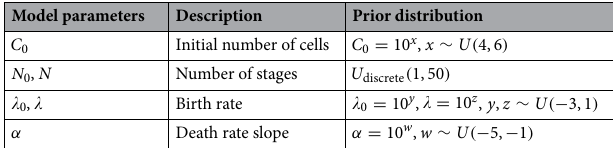
6 are taken 6.0 10 − = ×